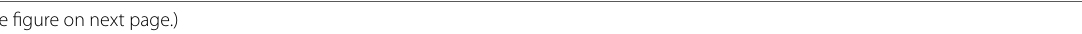
lost the marker NG2 and expressed a higher level of the fibroblast markers FSP1 and vimentin (Fig. 4h, i), indicat- ing that pericytes underwent pericyte-fibroblast transi- tion. In addition, Mye-CM-cultured pericytes expressed higher levels of extracellular matrix collagen I and